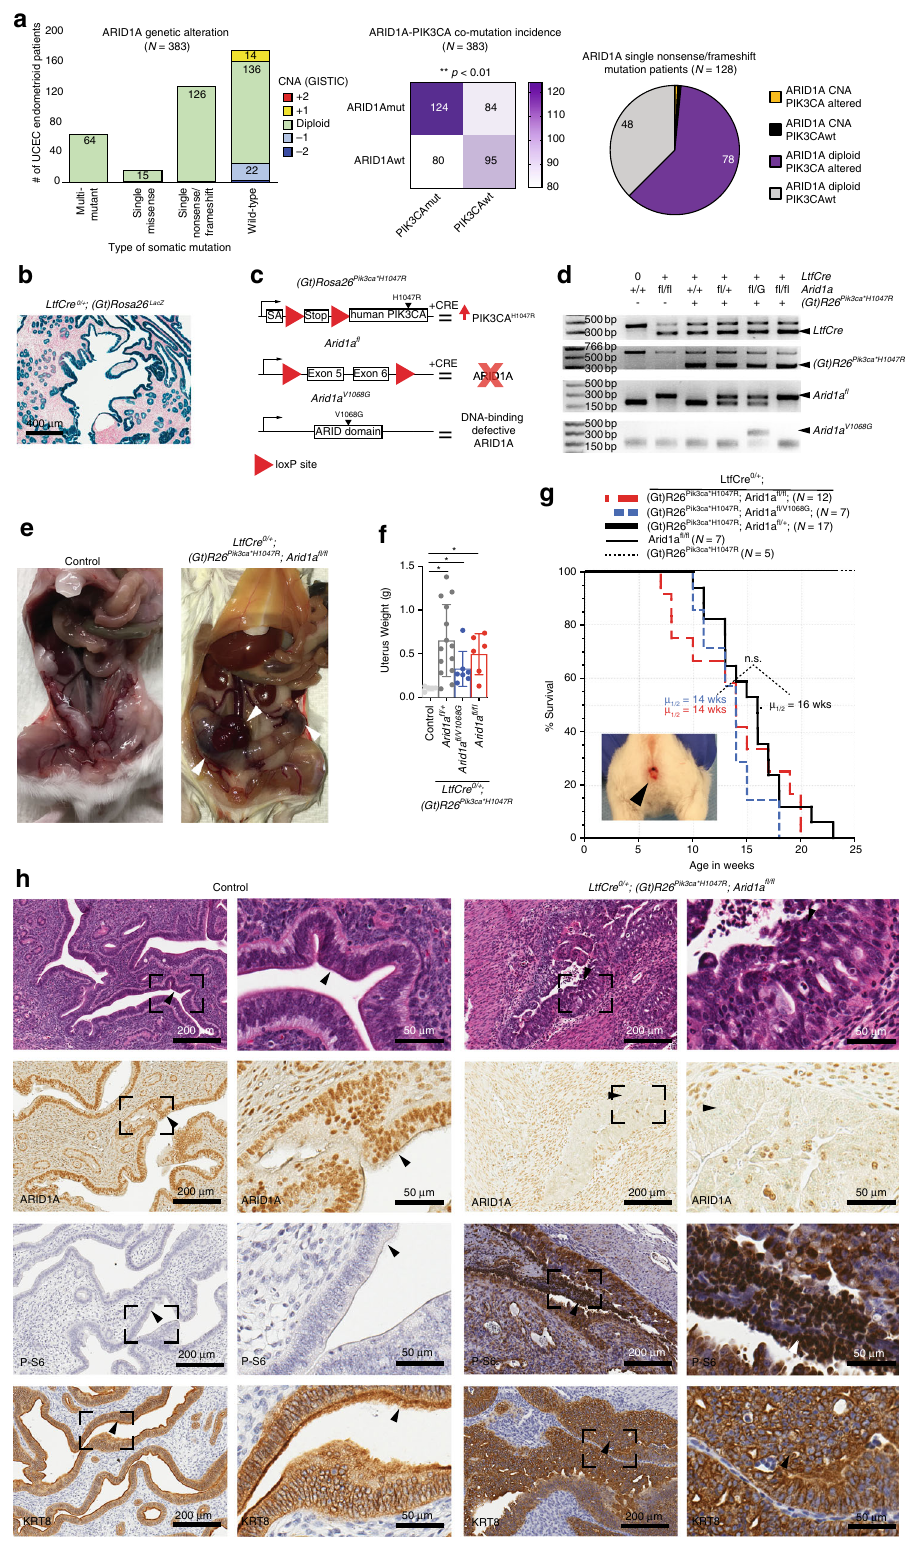
Mutant endometrial epithelium show hallmarks of EMT . To pro fi le in vivo gene expression changes in mutant endometrial epithelium at an early stage of transformation, we devised an enzymatic digestion and magnetic isolation protocol to positively enrich epithelial populations (Fig. 2a). Endometrial epithelial cells express EPCAM (Fig. 2b), and EPCAM expression is not altered NATURE COMMUNICATIONS| (2019) 10:3554